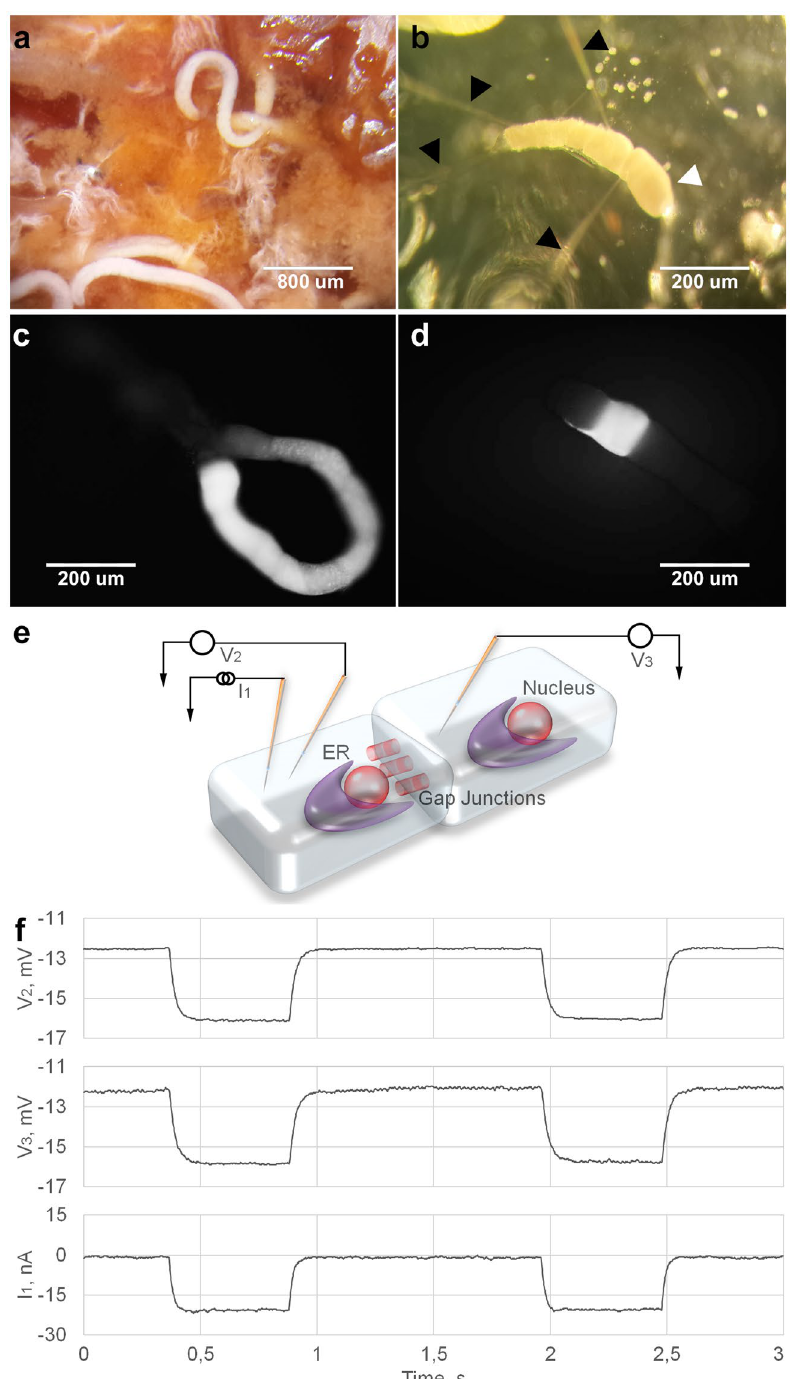
Figure 1. Gap junctions in H . megidis nematode gut. ( a ) H . megidis parasites inside a dissected insect. ( b ) Isolated preparation of a nematode gut (white arrowhead) with four intracellular microelectrodes (black arrowheads). ( c , d ) Fluorescent dye injections into a single gut cell. c Lucifer yellow CH diffuses to adjacent cells within several minutes. ( d ) Carboxyfluorescein retains in one cell after one hour after injection. ( e ) Scheme of experiment, in which two microelectrodes I 1 and V 2 are placed in one gut cell; V 3 electrode is inside the adjacent cell. ( f ) Impulse of negative current of − 20 nA is applied through I 1 . Deviation of membrane potentials in adjacent cells Δ V 2 and Δ V 3 is registered by V 2 and V 3 . Coupling coefficient is the ratio Δ V 3 / Δ V 2